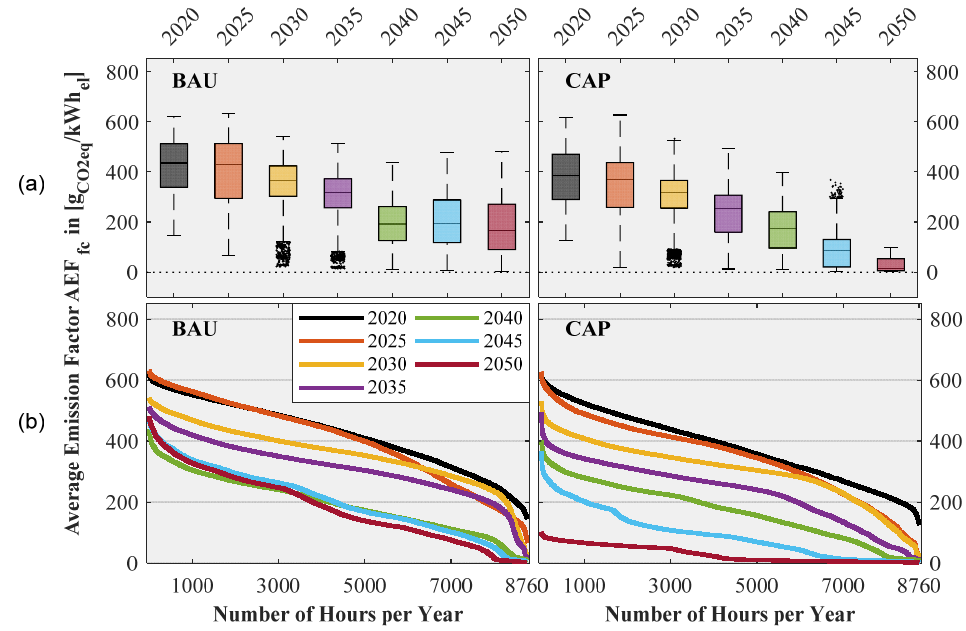
Figure 5. ( a ) Distribution of the AEF fc in 7 milestone-years in the two scenarios BAU and CAP shown in boxplots. Whisker length w = 1.5; q 3 + w · ( q 3 − q 1 ) < Outlier < q 1 − w · ( q 3 − q 1 ) . This corresponds approximately to 99.3 percent coverage if the data is normally distributed; ( b ) yearly duration curves of the corresponding scenarios and milestone-years. Model results.